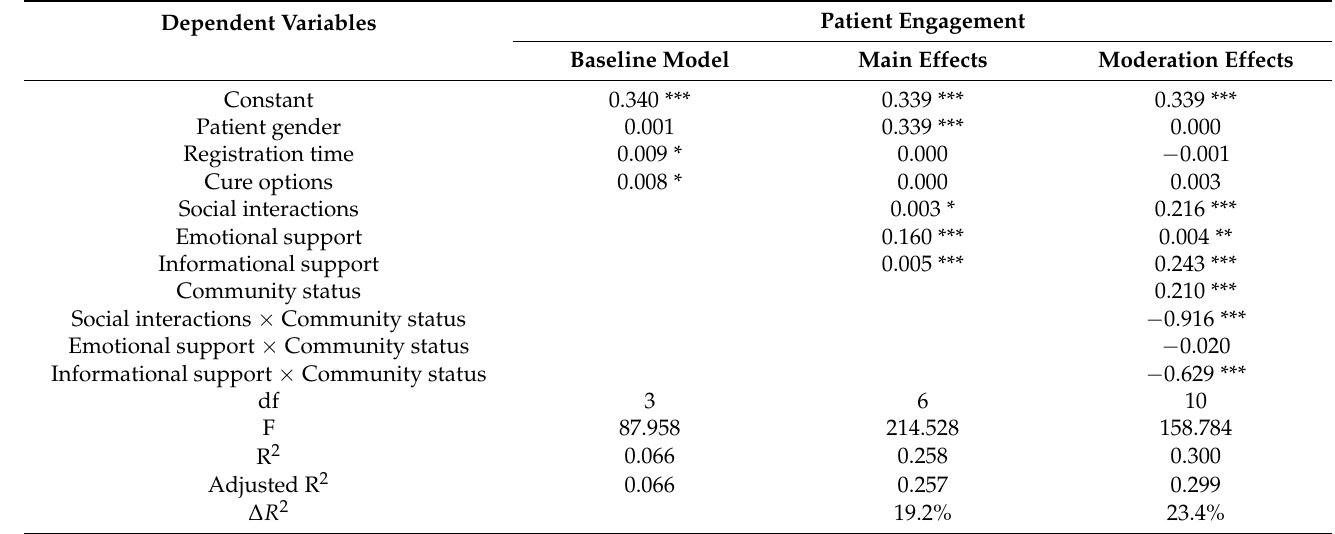
Table 5. The moderating effects of community status.